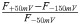
hVoS FRET quenching results.Typical fluorescence traces for oocytes expressing either wt hSGLT1 (panel A through C) or the hSGLT1 mutant C255A (panel D through I) which is known from a previous study [3] to present a cystein residue (C511) that is freely accessible for labelling from the external solution. Oocytes are simultaneously labeled with Alexa 488 (AL488, the donor) and Tetramethylrhodamine (TMR, the acceptor). In the absence of dipicrylamine (DPA, a negatively-charged amphiphatic fluorescence quencher), changing the membrane potential from -50 mV to +50 mV (black traces) or to -150 mV (red traces) produces very little change in the fluorescence intensities measured for C255A expressing oocytes using either one of the 3 filter sets (panel D to F). In the presence of DPA, oocytes expressing C255A present strong voltage-dependent fluorescent signals (panel G to I). This effect is specific for the fluorophores attached to C511 as wtSGLT1 (panel A to C) display much weaker voltage-dependent fluorescent signal. Panels J to L compare the mean voltage-dependent signal F+50mV−F−150mVF−50mV (mean ± SE) using the 3 filter sets for oocytes expressing wt SGLT1 (n = 5) or the mutant C255A (n = 15 to 17). Stars (*) denote statistical significance (C255A vs wt, p<0.05).